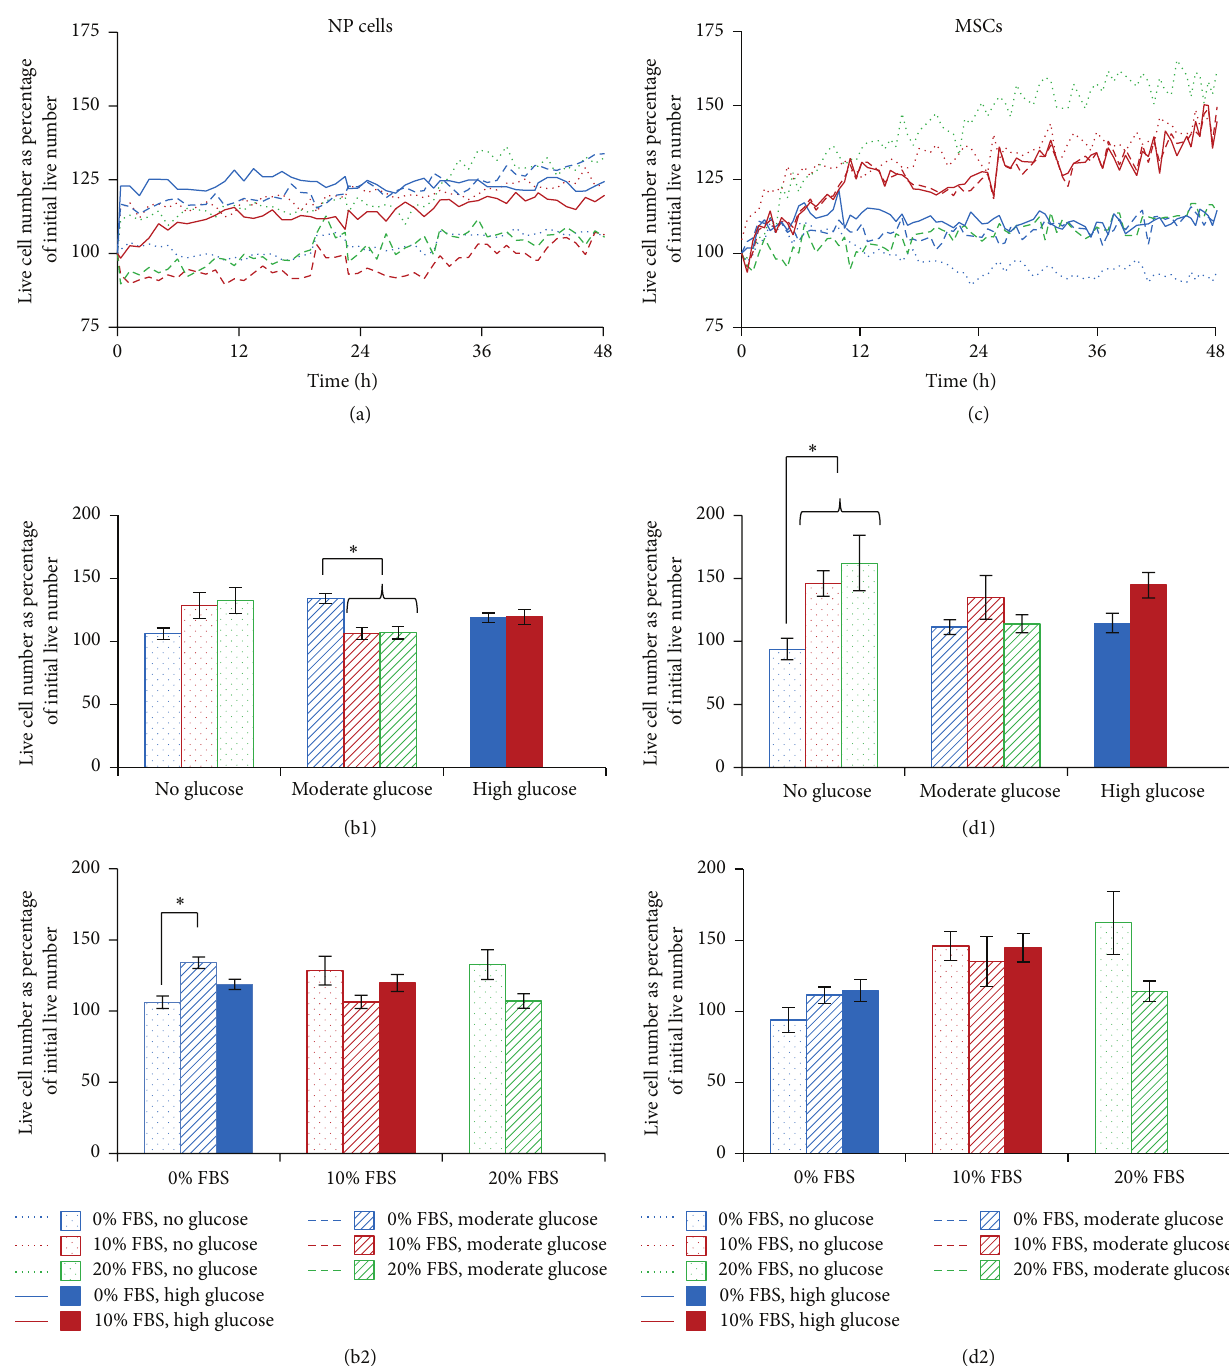
Figure 3: Temporal analysis of number of human NP cells and MSCs in response to altered FBS and glucose concentration, over 48 hours. Trends over 48 hours for human NP cells (a) and human MSCs (c) and at the end time point ( ± SEM) for human NP cells (b) and human MSCs (d), comparing FBS levels within glucose subgroups ((b1) and (d1)) and comparing glucose levels within FBS subgroups ((b2) and